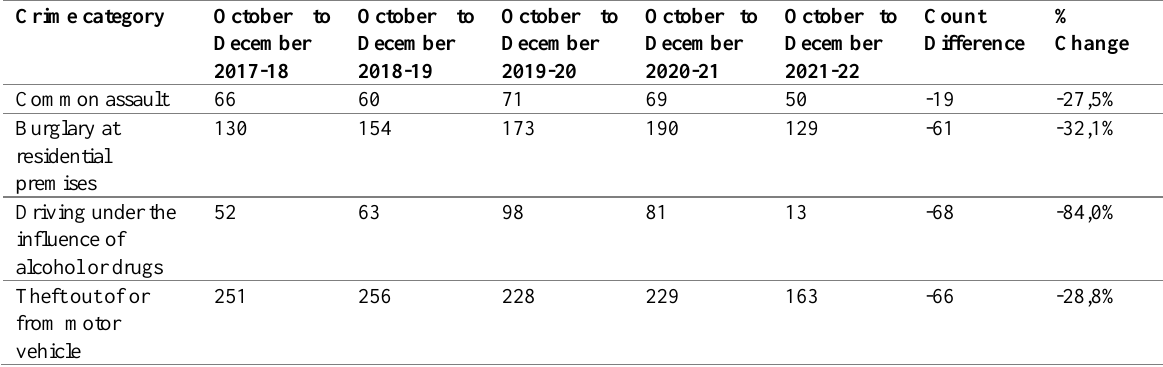
Table 1: Selected prevalent crimes at Brooklyn police station